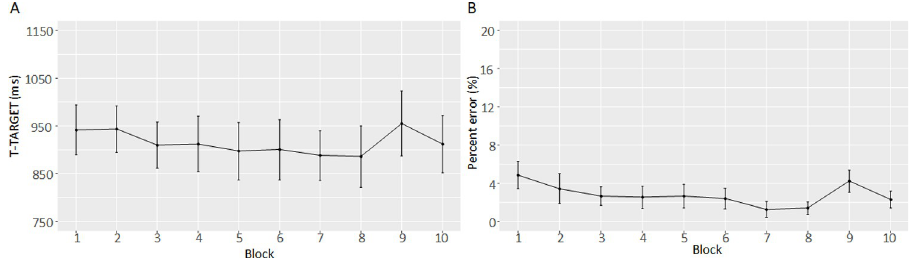
Fig 2. Performance curves of the (A) stepping response latencies and (B) percent error. In the Blocks 1, 2 and 9, the sequence of stimuli was random, while in the remaining Blocks 3 to 8 and 10 the respective target sequence was presented 6 times. T-TARGET: time point step onto pressure-sensitive mat. Error bars represent 95% confidence intervals.